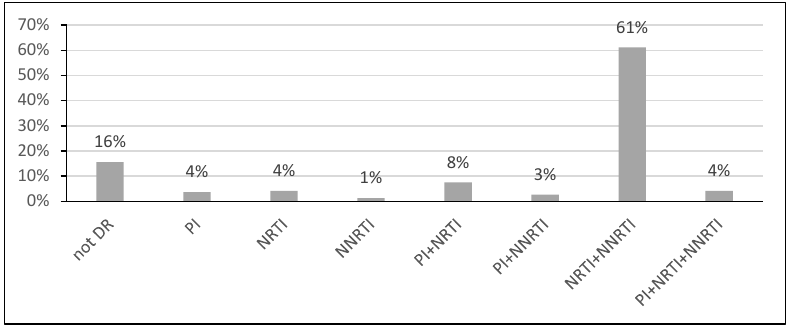
Figure 2. Prevalence of resistance to different drug classes in the study population. DR—drug resistance; PI—protease inhibitors; NRTI—nucleoside reverse transcriptase inhibitors; NNRTI—non-nucleoside reverse transcriptase inhibitors.